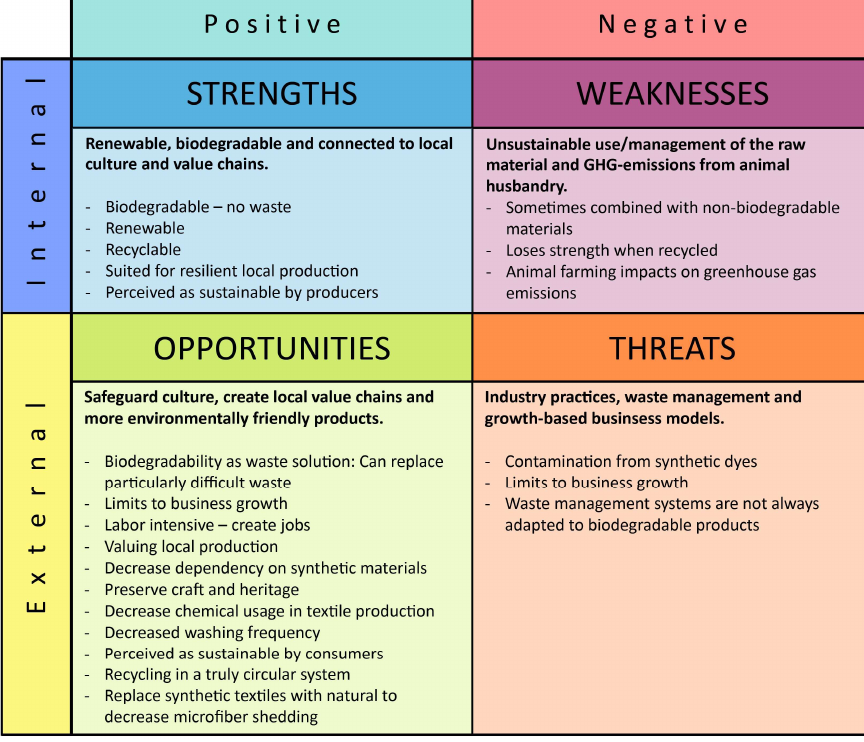
Figure 6. SWOT—Sustainability of coarse wool.